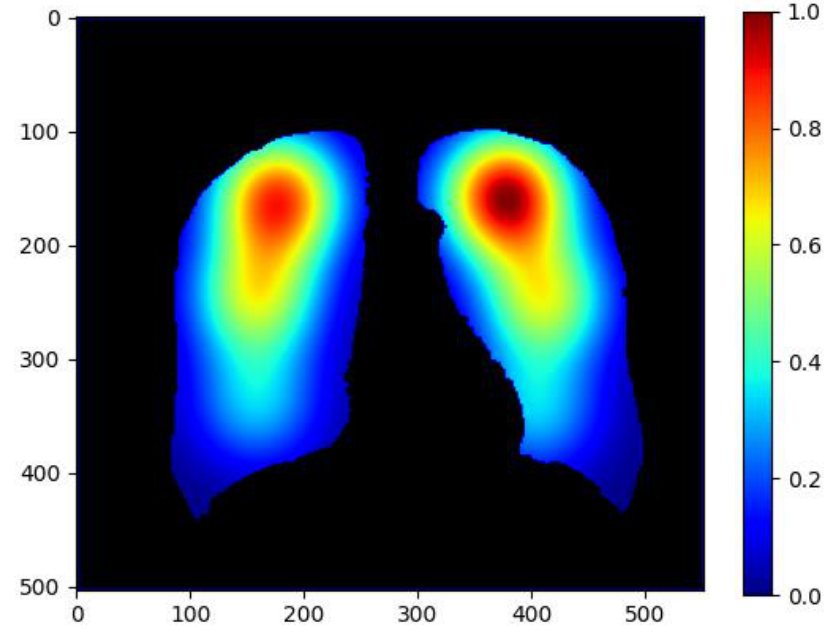
Figure 8. Abnormality occurrence heatmap in different regions of the lung derived from radiologists’ annotated sextant